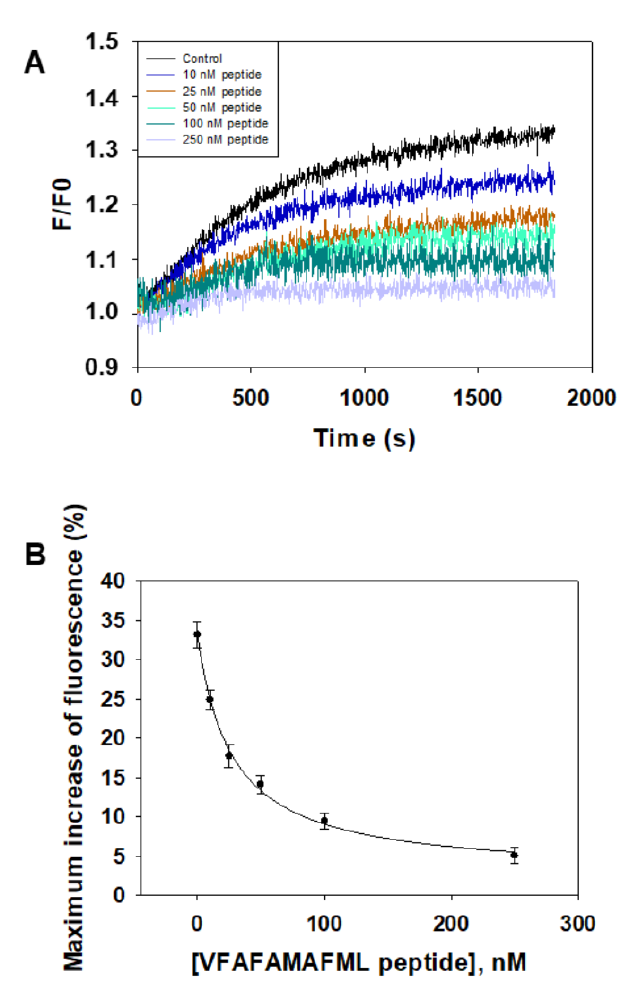
Figure 6. The synthetic peptide VFAFAMAFML (amidated-C-terminus amino acid) antagonizes A β (1–42):calbindin-D28k complex formation. ( A ) Effect of increasing concentrations of this synthetic peptide on the kinetics of increase of the fluorescence intensity of 10 nM A β (1–42) HiLyte TM -Fluor555 after the addition of 5 nM calbindin-D28k. Titration with the synthetic peptide and fluorescence measurements have been performed as indicated in the Materials and Methods. The kinetics of fluo- rescence were recorded in the presence of the following concentrations of the peptide VFAFAMAFML (amidated-C-terminus amino acid): 0 (black), 10 nM (dark blue), 25 nM (brown), 50 nM (cyan), 100 nM (green) and 250 nM (grey). ( B ) Plot of the dependence of the maximum increase of fluorescence recorded 1700 s after the addition of calbindin-D28k as a function of the concentrations of the peptide VFAFAMAFML (amidated-C-terminus amino acid). The data shown are the average (black-filled circles) ± S.E. (error bars) of the results obtained in triplicate measurements. The continuous line is the non-linear square fit of the data to the hyperbolic equation for a one site binding drug-inhibitory effect: Y = Y0 − [Qmax × x/(IC50 + x)], where Y0 is the maximum fluorescence increase in the absence of the peptide, Qmax is the maximum quenching of the increase of fluorescence at saturation of the peptide and IC50 is the concentration of the peptide that reduces to half the maximum increase of fluorescence. The data fitting gave the following results: R 2 = 0.99694, Y0 = 33%, Qmax = 33% and IC50 = 27 ± 3